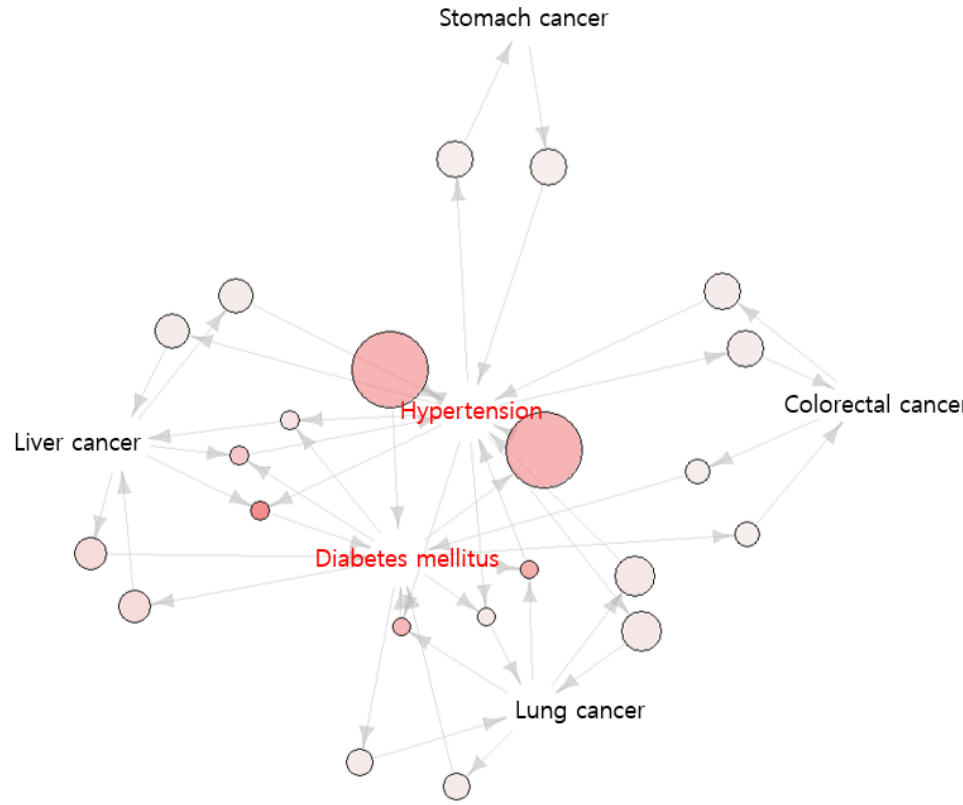
Figure 1. Network analysis for association rule mining. The size refers to support, and the color of the circle means lift. Diabetes mellitus and hypertension are at the center of the graph. It confirms that related cancer diseases in the vicinity form a path with diabetes mellitus and hypertension.